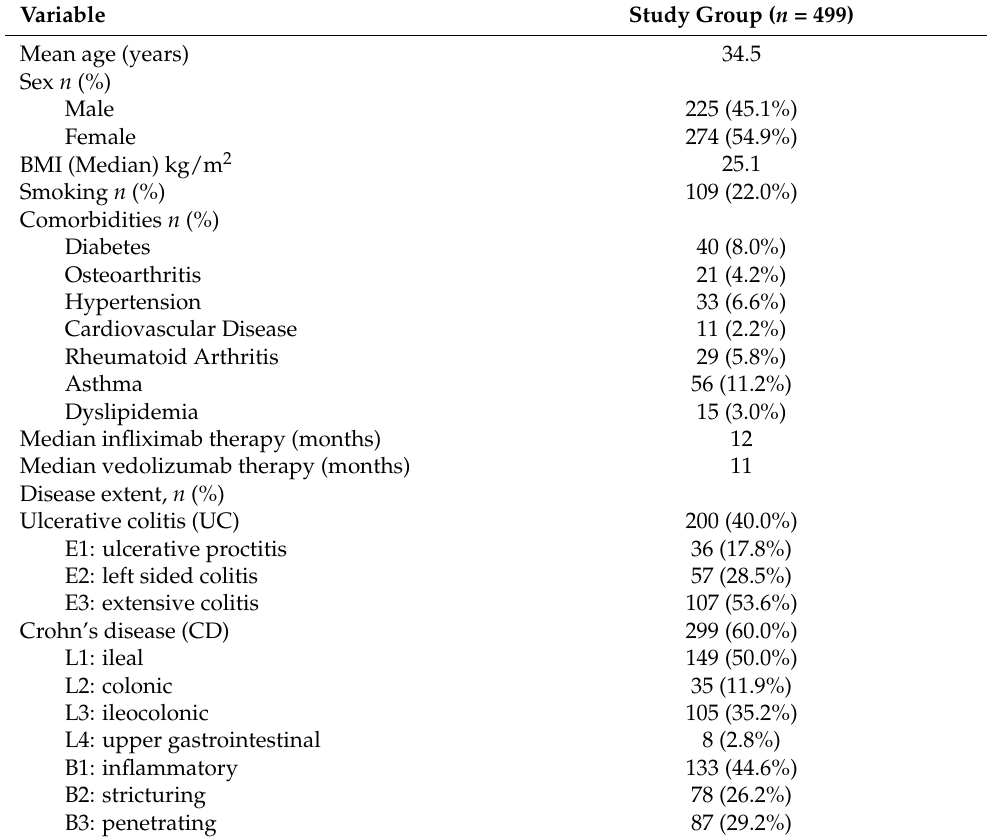
Table 1. Demographics of patients with